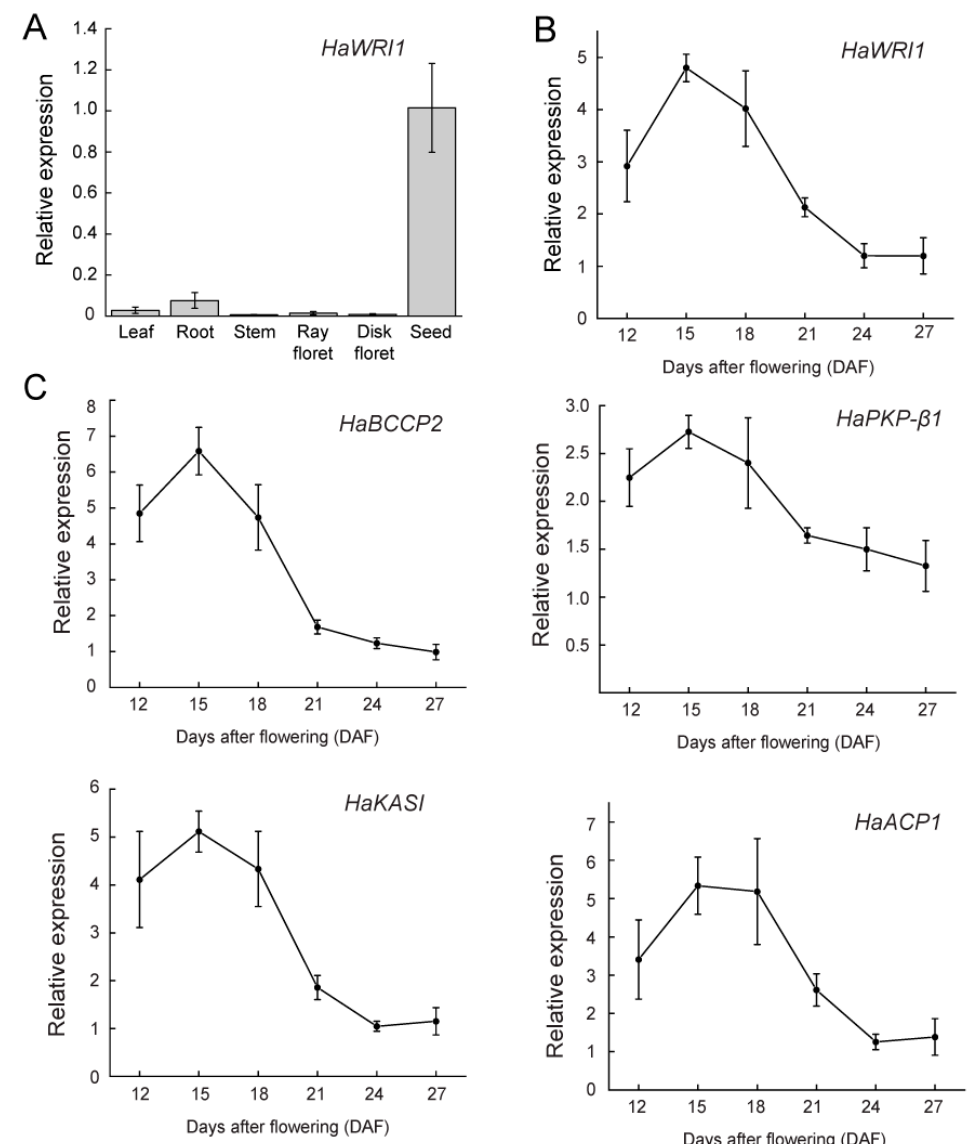
Figure 2. Expression analysis of HaWRI1 and WRI1 target genes in a variety of H. annuus tissues by quantitative real-time PCR (qRT-PCR). ( A ) HaWRI1 expression in different tissues of H. annuus plants as indicated. Results are shown as means ± SE ( n = 3). ( B ) HaWRI1 expression at various stages during seed development [12–27 days after flowering (DAF) as indicated]. Results are shown as means ± SE ( n = 4–5). ( C ) Expression analysis of selected genes known as WRI1 targets in developing seeds of H. annuus . Expression level of HaBCCP2, HaPKP- β 1, HaKASI, and HaACP1, at various stages during seed development (12–27 DAF as indicated) was quantified by qRT-PCR. Results are shown as means ± SE ( n =